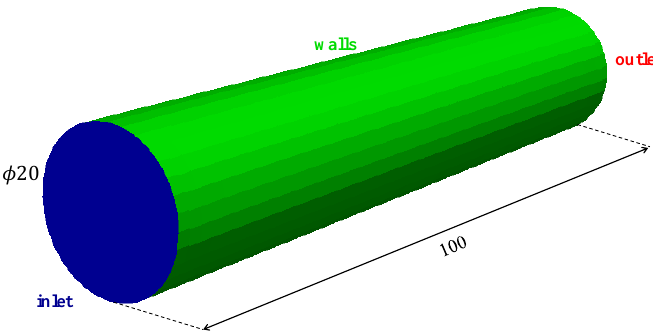
Figure 3. Geometry of the cylindrical cavity for Case Study 1 (dimensions in mm).